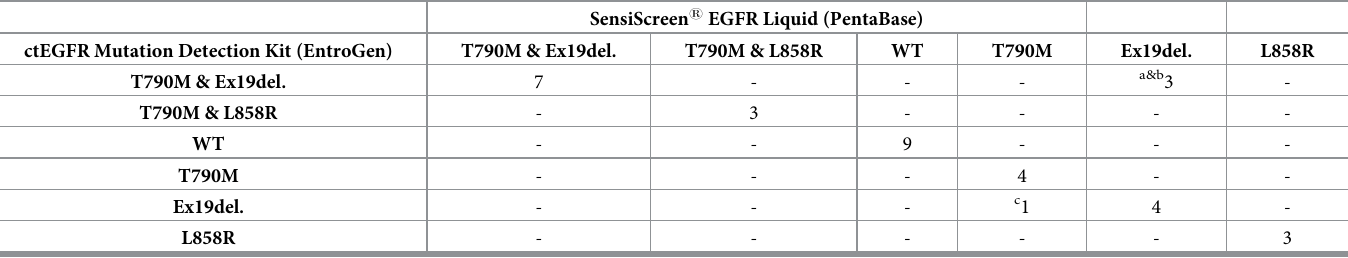
Table 3. Overview of the EGFR phenotypes detected by the SensiScreen 1 EGFR Liquid assay (PentaBase ApS) versus the ctEGFR Mutation Detection Kit (Entro- Gen) using cohort II and agreement or disagreement between platforms (N = 34). SensiScreen 1 EGFR Liquid (PentaBase) ctEGFR Mutation Detection Kit